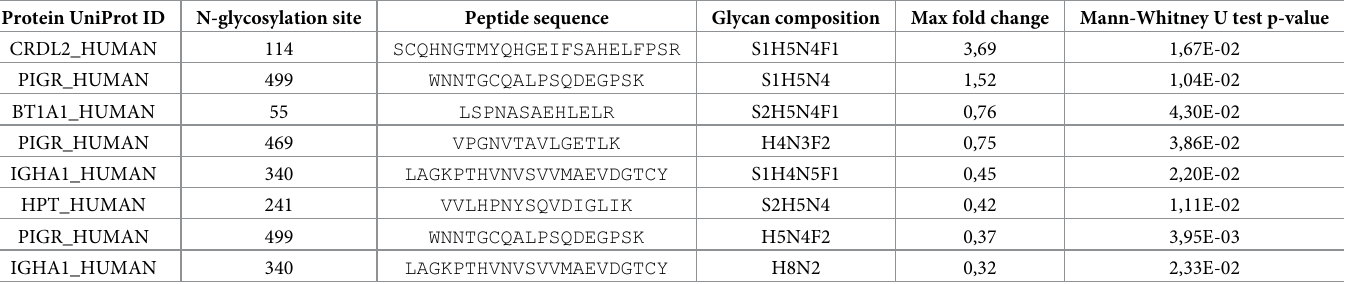
Table 3. The eight significant (p < 0.05) glycopeptides identified, given according to fold change, when samples were compared between children who developed atopic disease and children who did not. Further details can be found in S4